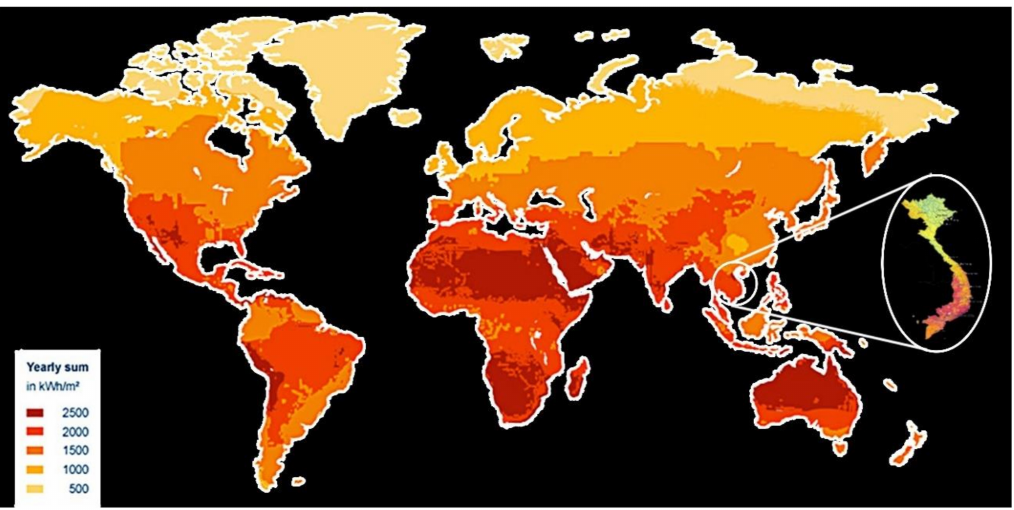
Figure 2. Average amount of potential solar energy output